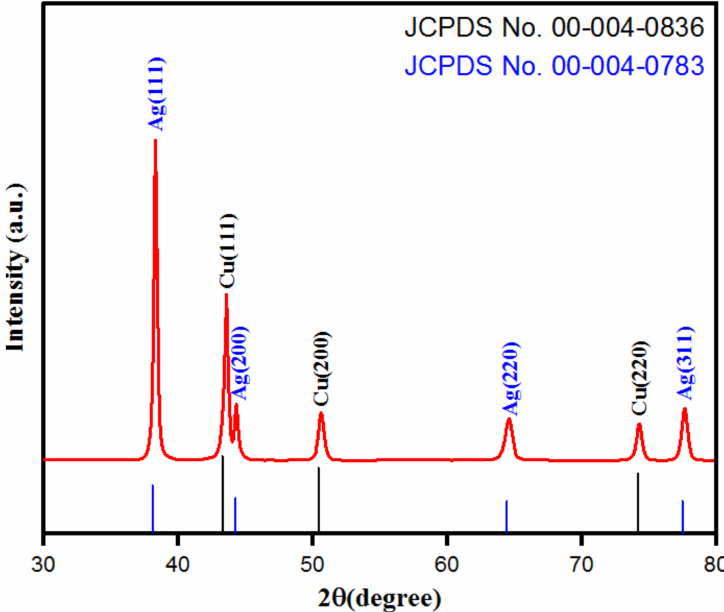
Figure 5. X-ray diffraction (XRD) pattern of Beta vulgaris assisted Ag-Cu bimetallic